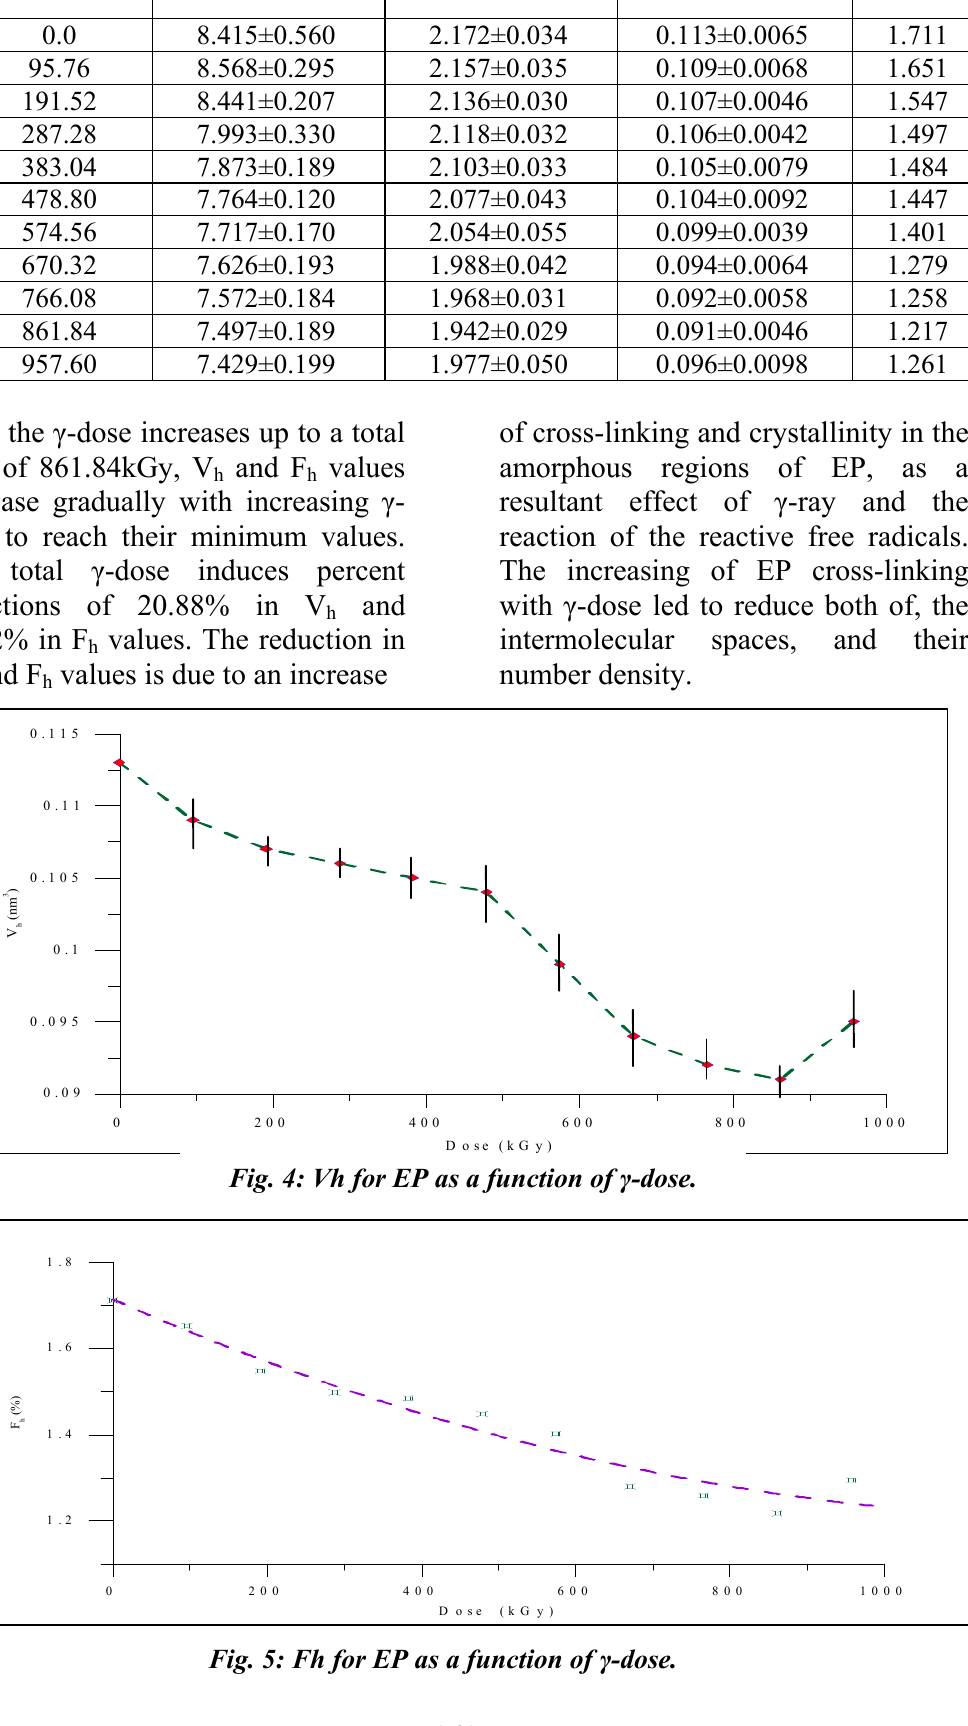
Table 2: The Lifetime parameters of EP as a function of γ -dose. Dose (kGy)